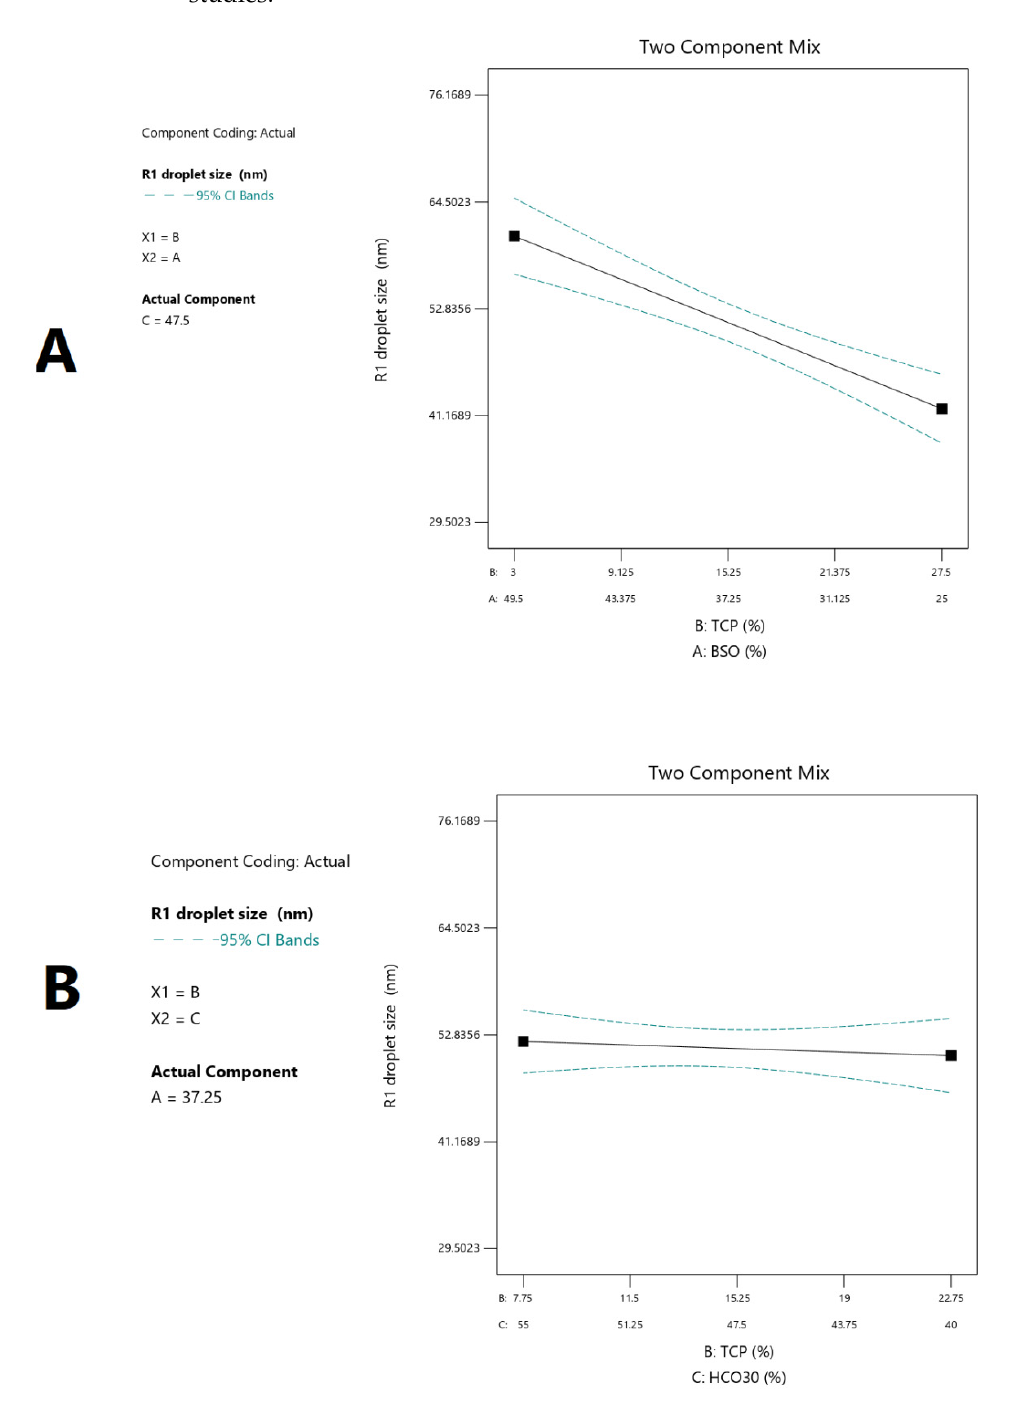
Figure 10. Two-component design graph of the effects of cosolvent TCP proportion on droplet size in case of maintaining the ( A ) surfactant proportion and ( B ) oil proportion at constant levels. As per the current dissolution data, pure RMP showed >85% release within 15 min.